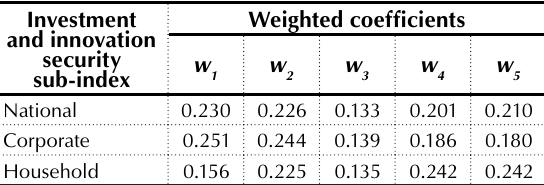
Table 5. Coefficients of the weighted investment and innovation security sub-indices